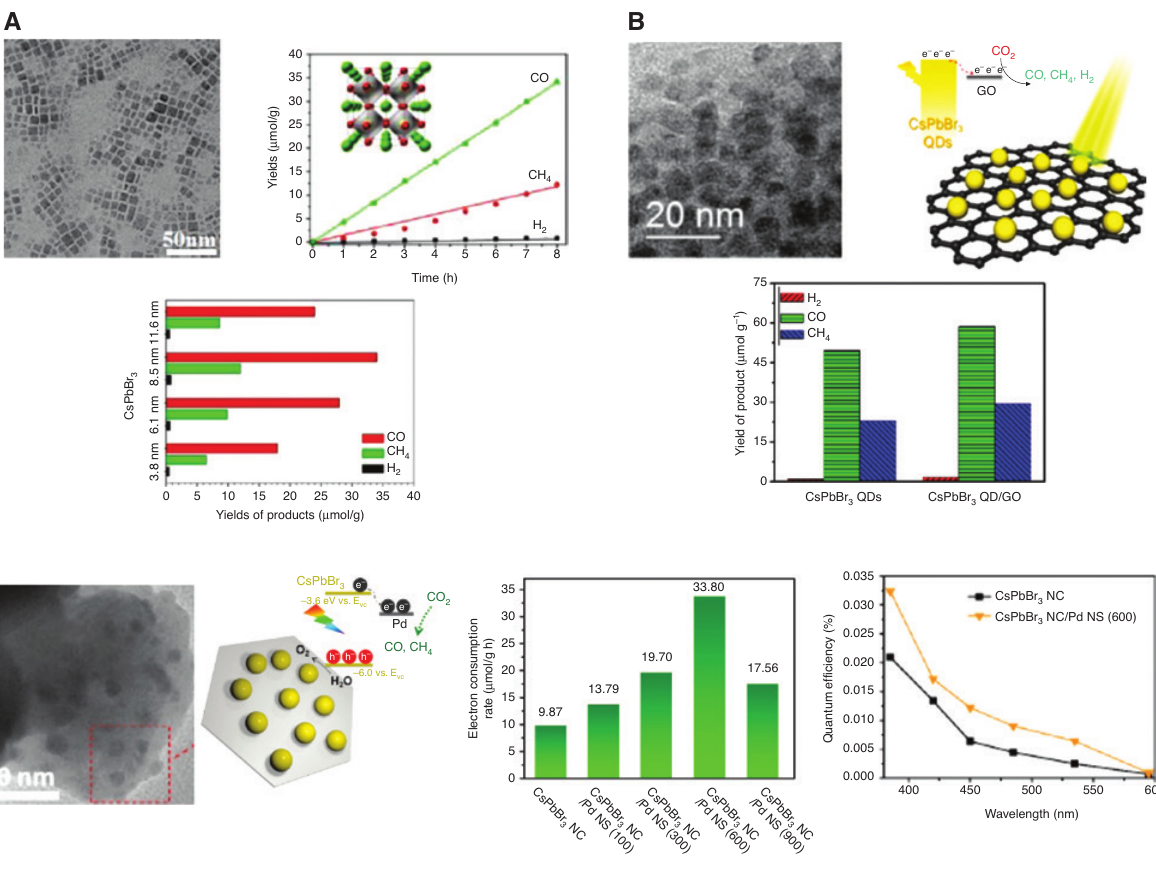
reduction. Figure 7: Metal halide nanocrystals for photocatalytic CO 2 (A) Single phase CsPbBr nanocatalysts. Reproduced with permission from [22]. Copyright 2017, Wiley-VCH. (B) Composite CsPbBr 3 catalysts. Reprinted with permission from ref [24]. Copyright (2017), American Chemical Society. (C) Composite CsPbBr Reprinted with permission from [217]. Copyright (2018), American Chemical